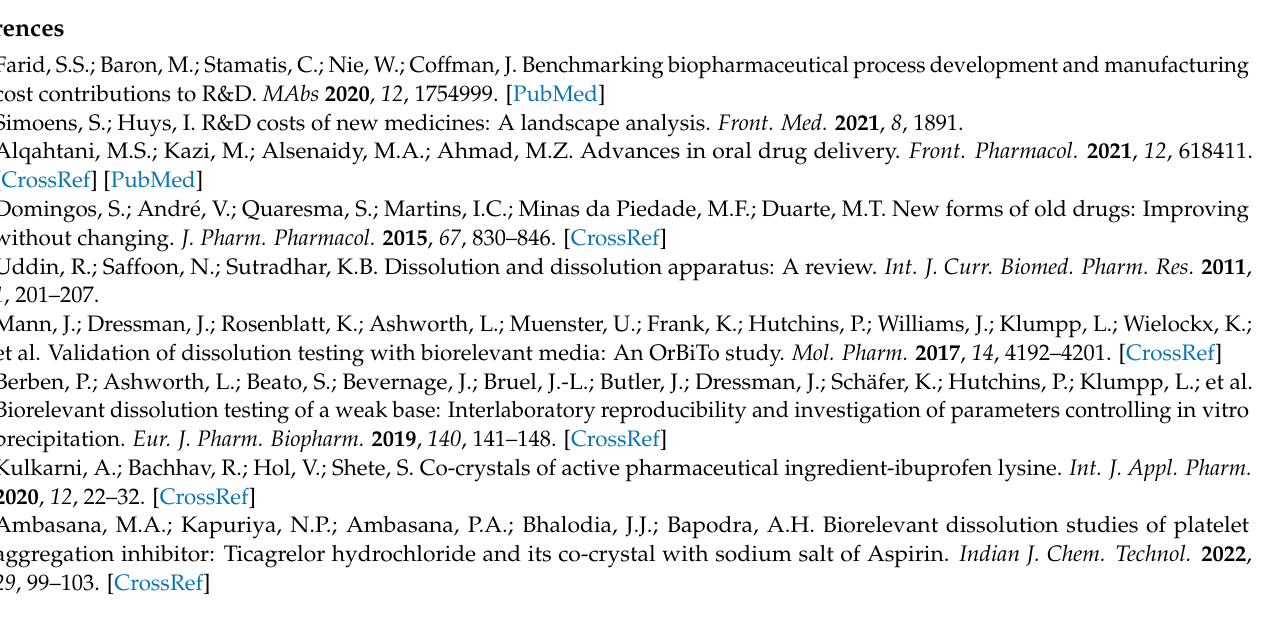
Figure A2. Image processing of the red channel images: ( a ) original image, ( b ) red channel, ( c ) binarized image, ( d ) masked crystal and skeletonized fringes, ( e ) determination of diffusive layer thickness, ( f ) selected fringe segments, ( g ) interference fringes with assigned phase shifts as a multiple of 2 𝜋 together with the fringes of a hypothetical homogeneous concentration field (dashed lines) and ( h ) calculated concentration field.